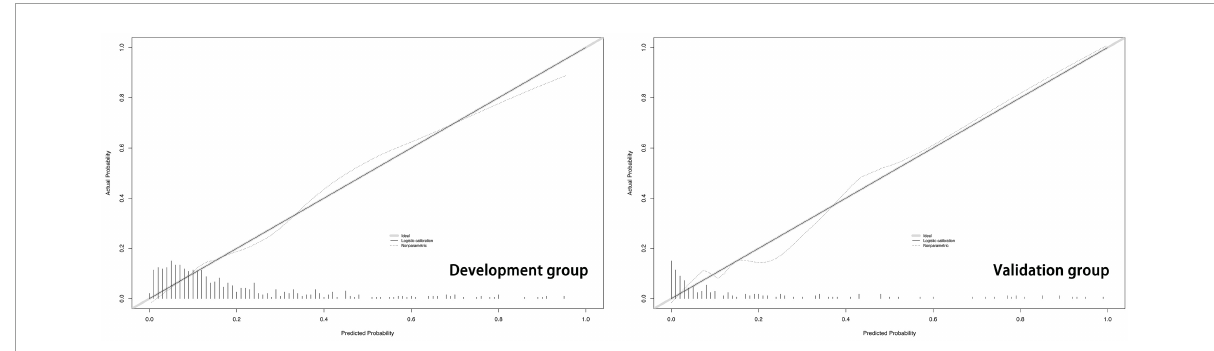
FIGURE4 The Calibration plots based on the